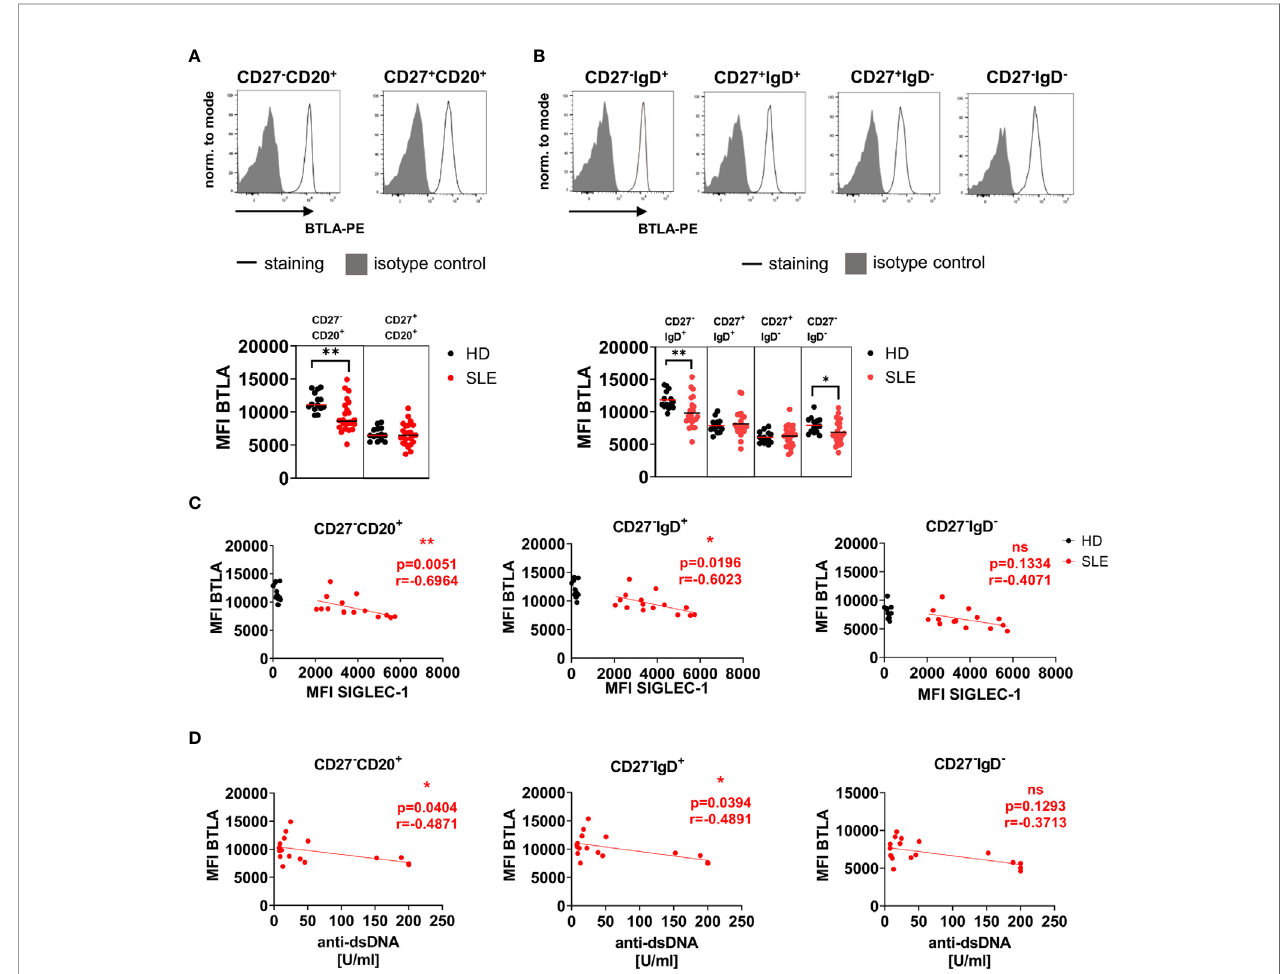
FIGURE 1 | BTLA surface expression is reduced on naïve SLE B cells and inversely correlates with SIGLEC-1 (CD169) expression and anti-dsDNA antibody titers in SLE patients. (A, B) Representative histograms of BTLA expression and isotype control on B cell subsets in HD de fi ned by CD27 and CD20 (A) and CD27 and IgD (B) derived from peripheral blood and summary data (MFI) for SLE patients and HD. Bars represent median. HD n=14, SLE n=24, Mann-Whitney U Test. (C) Spearman ’ s rank correlation of BTLA expression (MFI) on CD27 - CD20 + , CD27 - IgD + and CD27 - IgD - B cells with SIGLEC-1 expression on CD14+ monocytes in patients with SIGLEC-1 MFI >2000, HD are shown as control (HD n=12, SLE n=15). (D) Spearman ’ s rank correlation of BTLA surface expression (MFI) on CD27 - CD20 + , CD27 - IgD + and CD27 - IgD - B cells with anti-dsDNA antibody titers (U/ml, n=18). *p < 0.05, **p < 0.01, ns means not signi fi